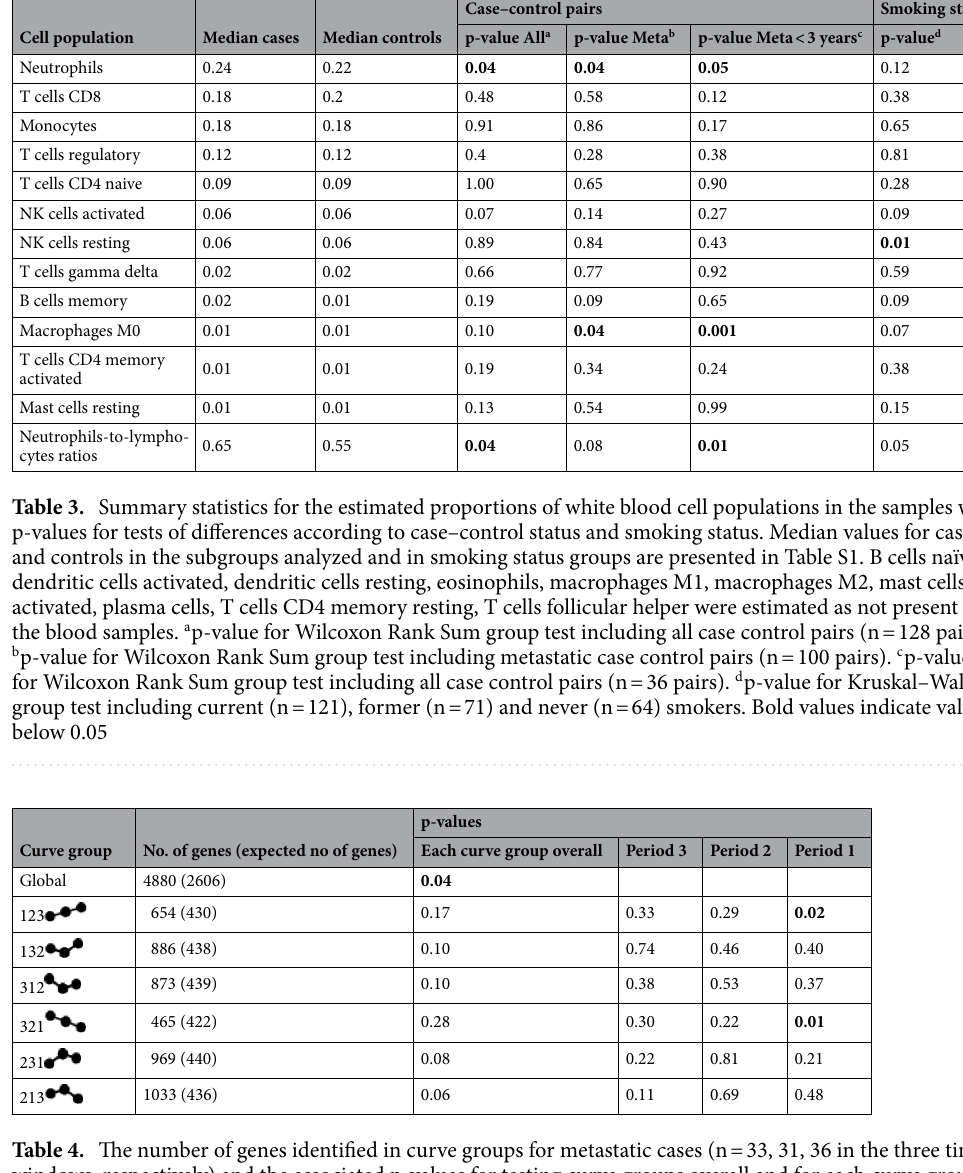
(Table 5). Among the genes identified for years 2 and 3, 20 genes overlapped (indicated in Table S7) and 14 of